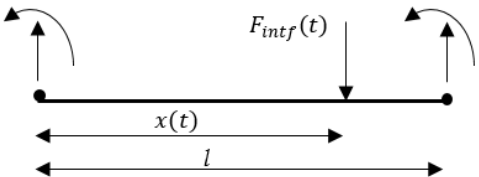
Figure 2. An element under moving